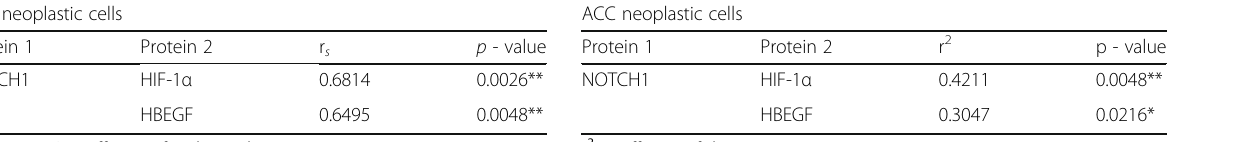
Table 4 Positive Spearman ’ s rank correlation test of the labelling area of proteins in neoplastic cells of ACC ACC neoplastic cells Protein 1